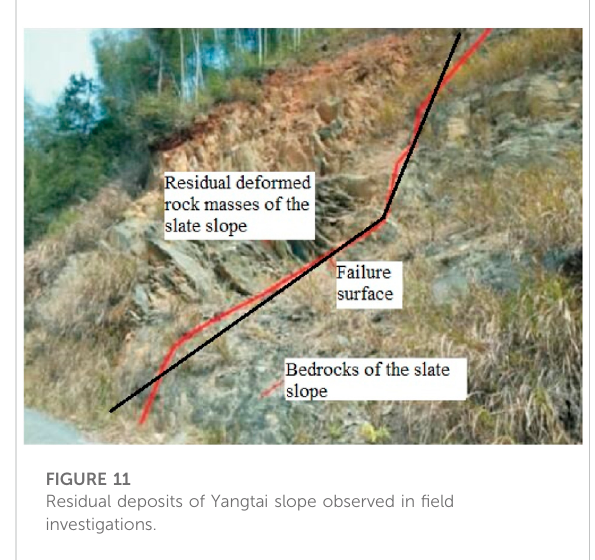
FIGURE 11 Residual deposits of Yangtai slope observed in fi eld investigations.